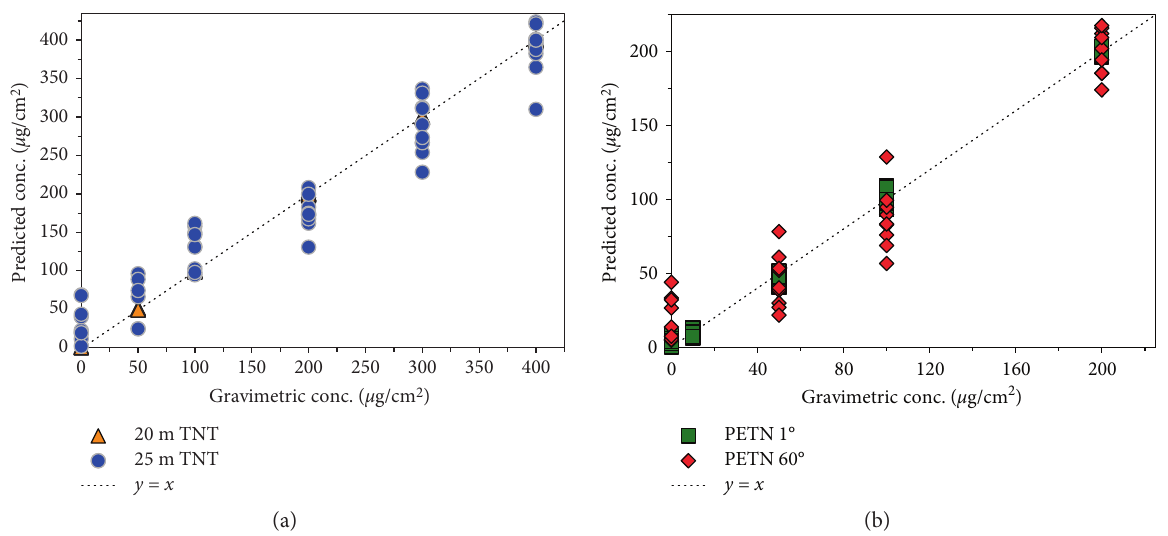
Figure 5: (a) Predicted versus true surface concentration for TNT explosives on Al plates at 20m and 25 m. (b) Predicted versus true surface concentration for PETN explosives on Al plates at 1 ° and 60 °